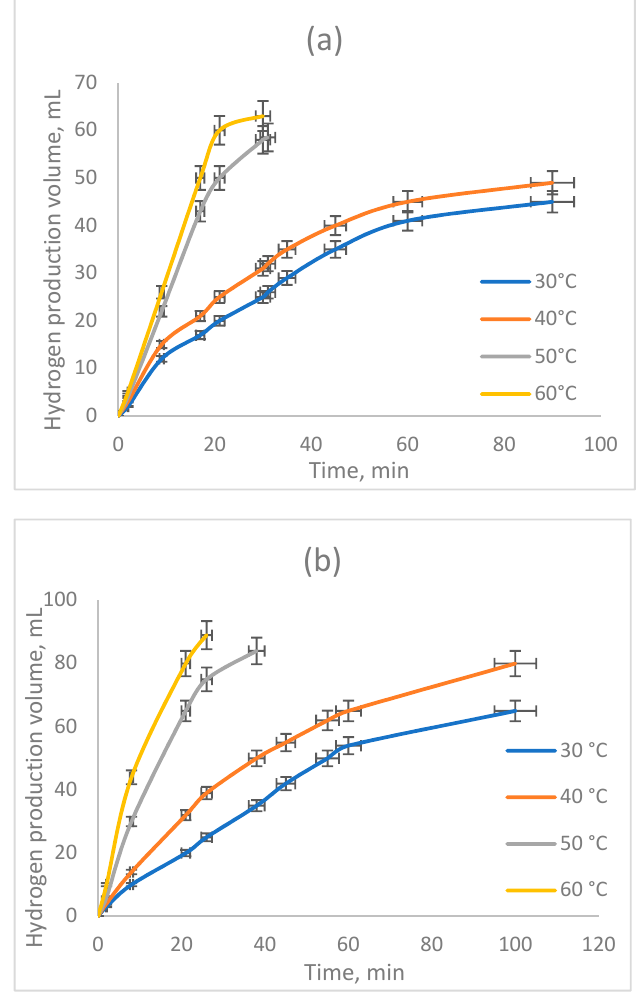
Figure 7. Plots of the effect of temperature on the produced hydrogen volume versus time. ( a ) DMAB graph and ( b ) LiBH 4 graph.